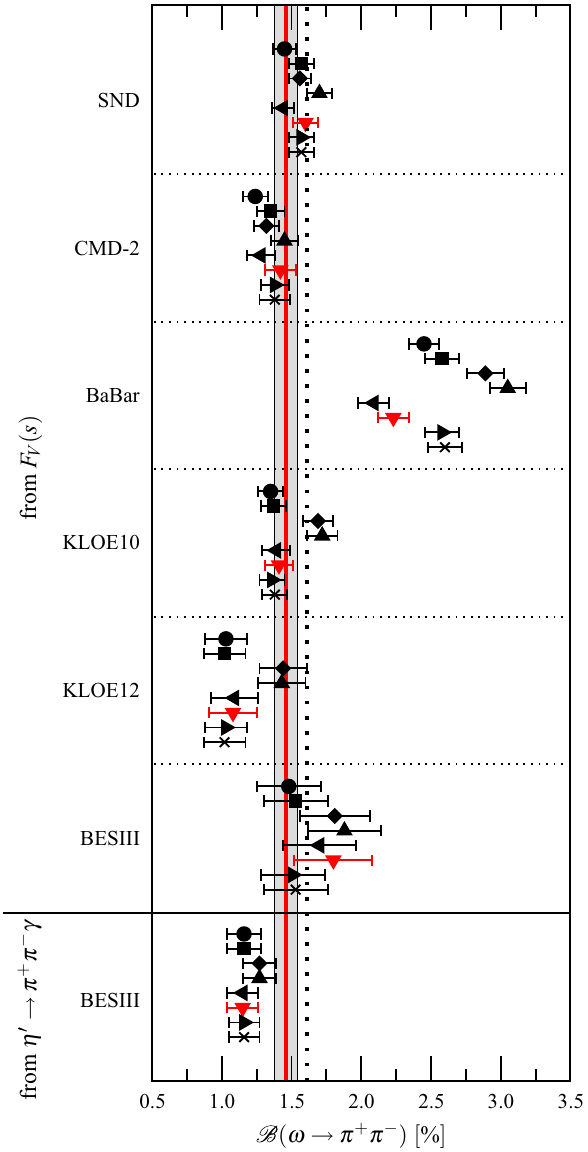
Fig. 3 Comparison of the values for the branching ratio for ω → π + π − extracted from the various fits to the different data sets, where circles refer to Fit 1, squares to Fit 2, diamonds to Fit I, the triangles- up to Fit II, triangles-left to Fit 1- ρ ( red ) triangles-down to Fit 2- ρ , triangles-right to Fit 1- φ , and crosses to Fit 2- φ . The red thick solid line denotes the average of the values, the gray band the corresponding uncertainty found from our preferred analysis – Fit 2- ρ – omitting the contribution from BaBar. The average with the BaBar value included is shown as the perpendicular dotted line . Note that the values extracted from η (cid:5) → π + π − γ refer to pseudo-data generated according to pre- liminary results